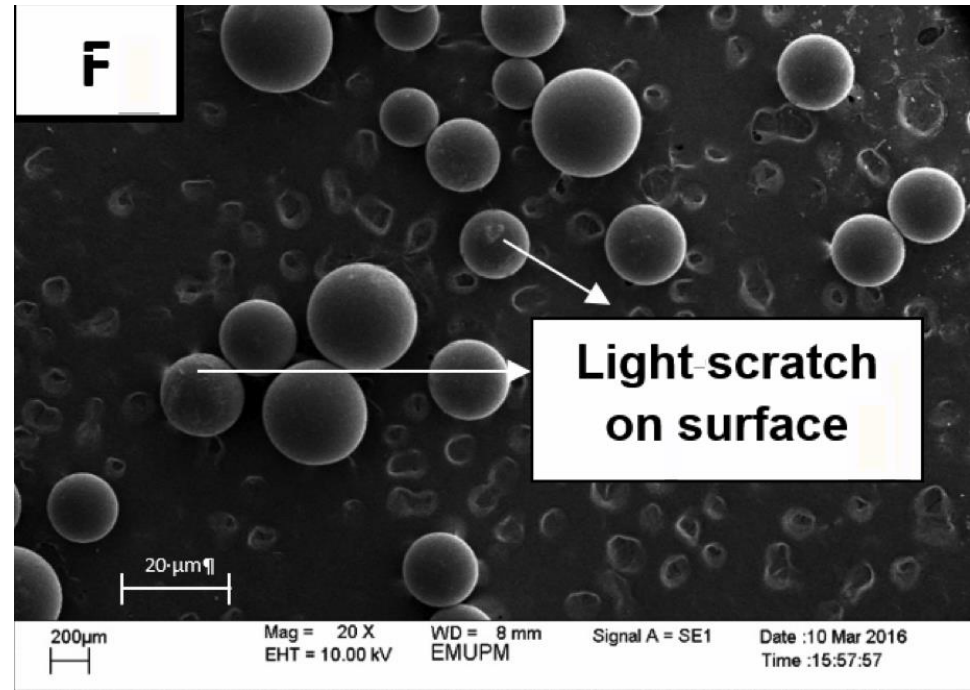
Figure 4. Scanning electron photograph of cell morphology mutant gdhA P. multocida B:2 (magnification × 10,000) in a 2 L stirred-tank bioreactor ( A ), without resin ( B ), with dispersed resin ( C ), with resin in internal column and surface structure resins Amberlite 86 (magnification × 200). ( D ) Control surface with smooth surface on resins. ( E ) Crack on the surface dispersed resins. ( F ) Light scratch on surface resins in internal column.